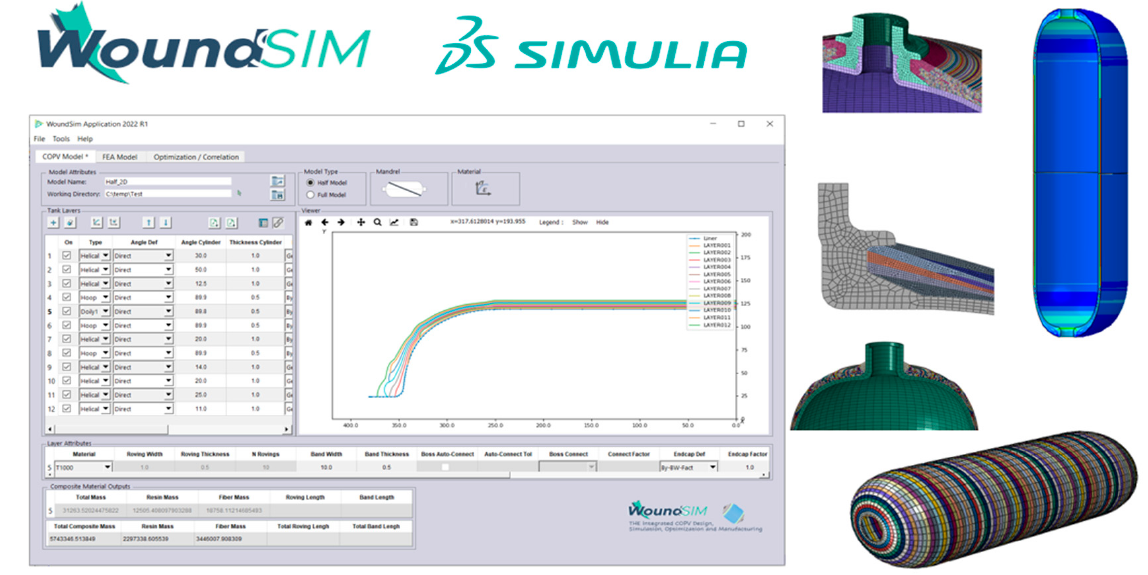
Figure 16. WoundSIM software